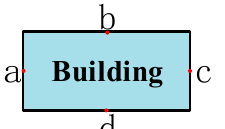
Figure 10. Depiction of chosen lines for noise calculation.